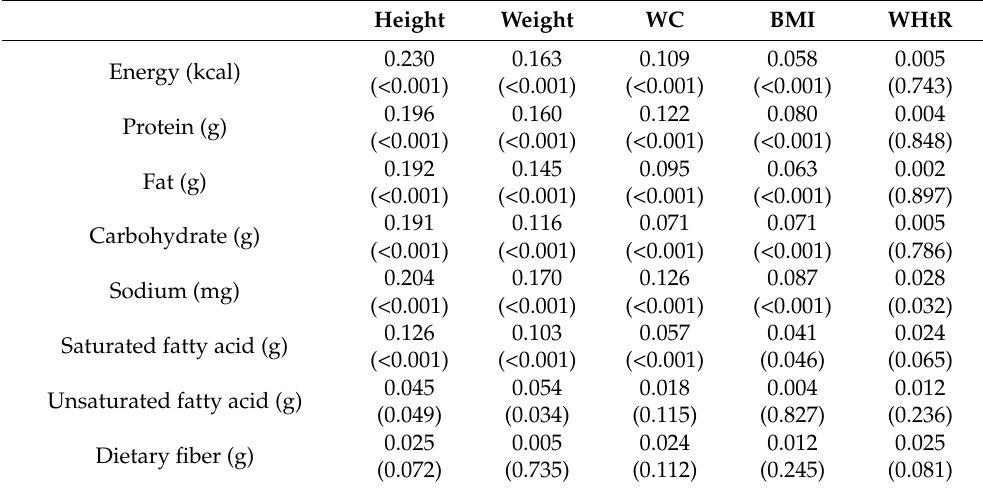
Table 2. Correlation between body composition and nutrition intake. Data expressed as correlation coefficient ( p